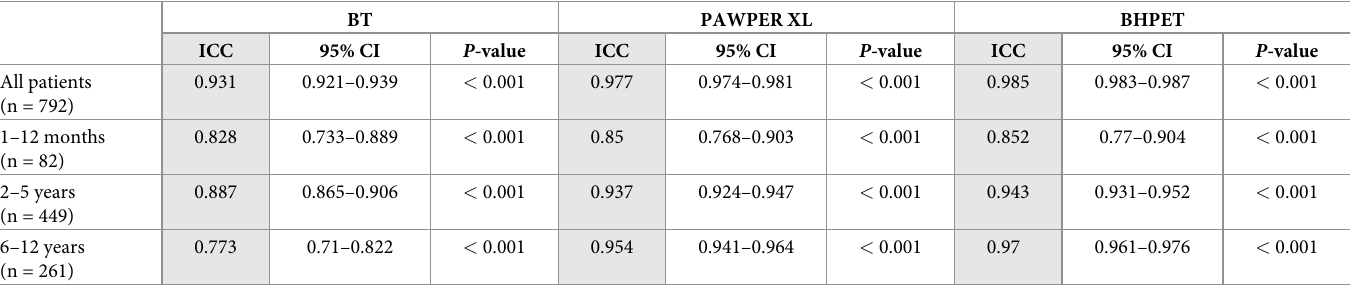
Table 3. Correlation between actual and estimated weight by age group.